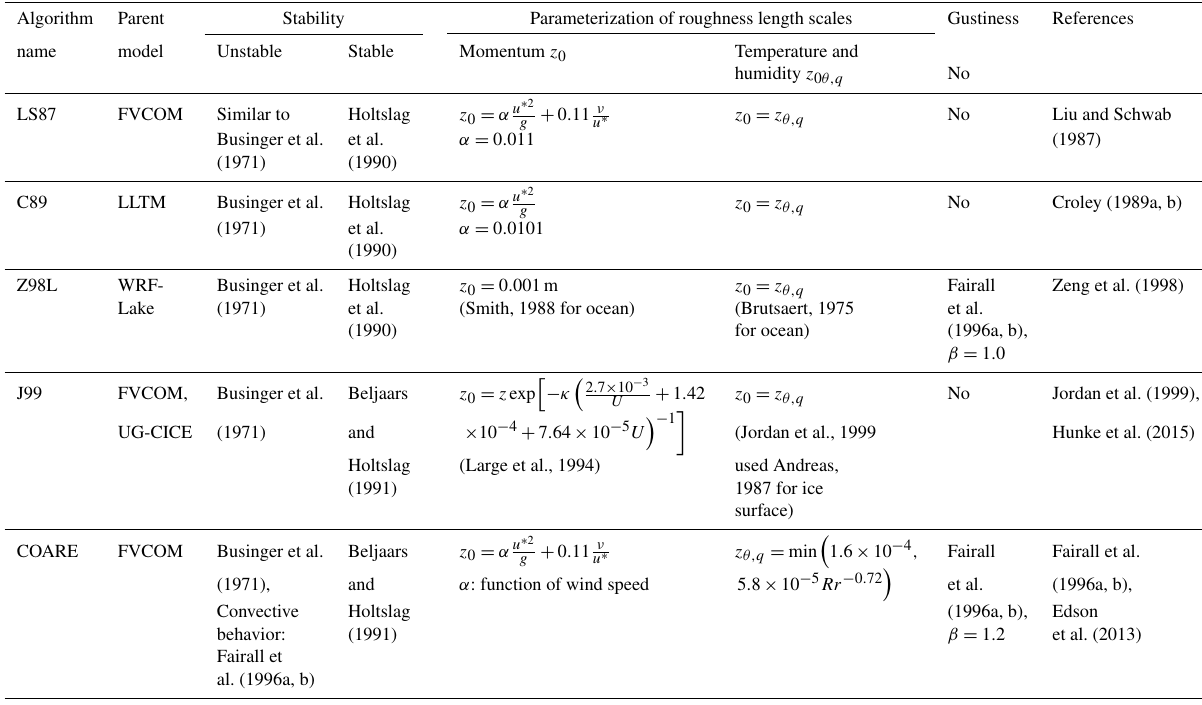
Table 1. Summary of flux algorithm specifications. Algorithm